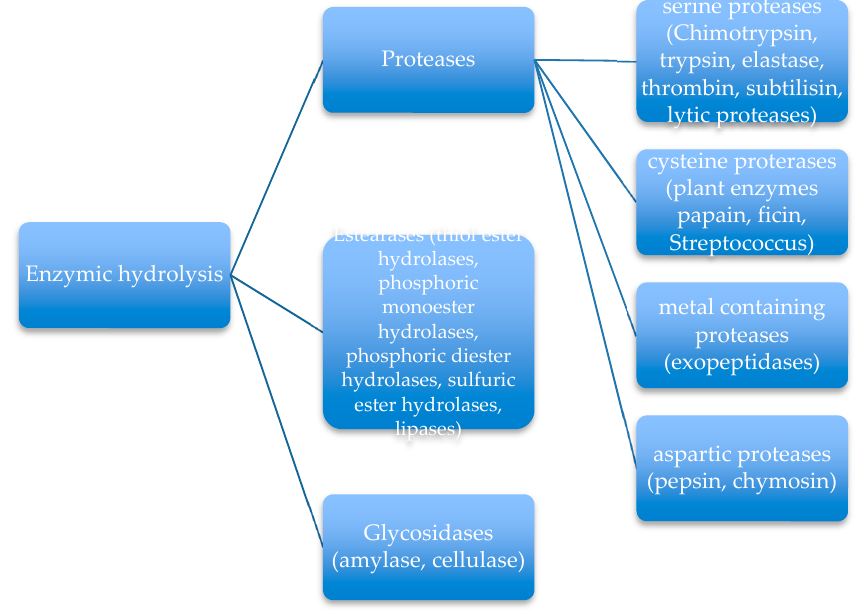
Figure 3. Enzymic Figure 3. Enzymic hydrolysis.